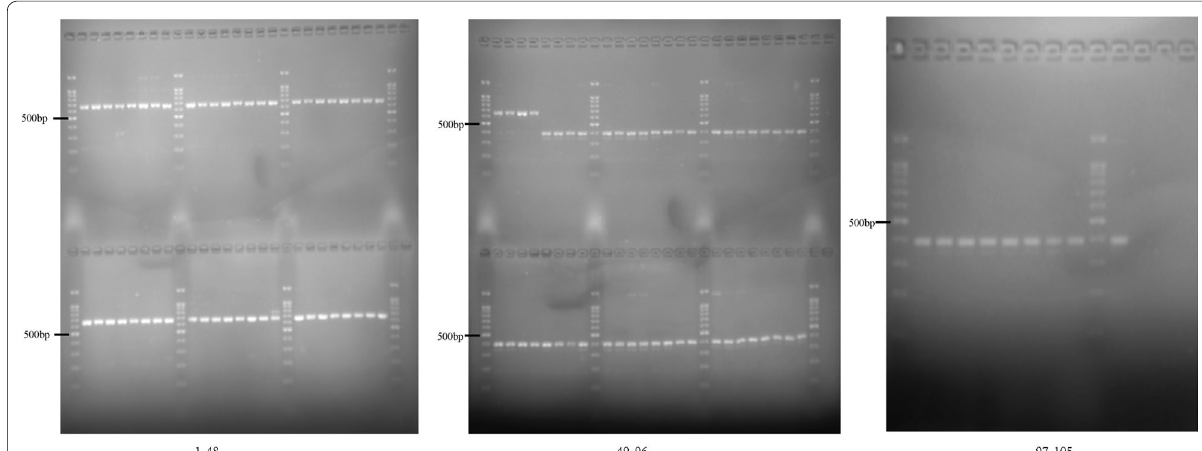
Fig. 3 PCR amplified products from M. abscessus and M. massiliense . Amplified erm (41) products of M. abscessus were larger than those of M.